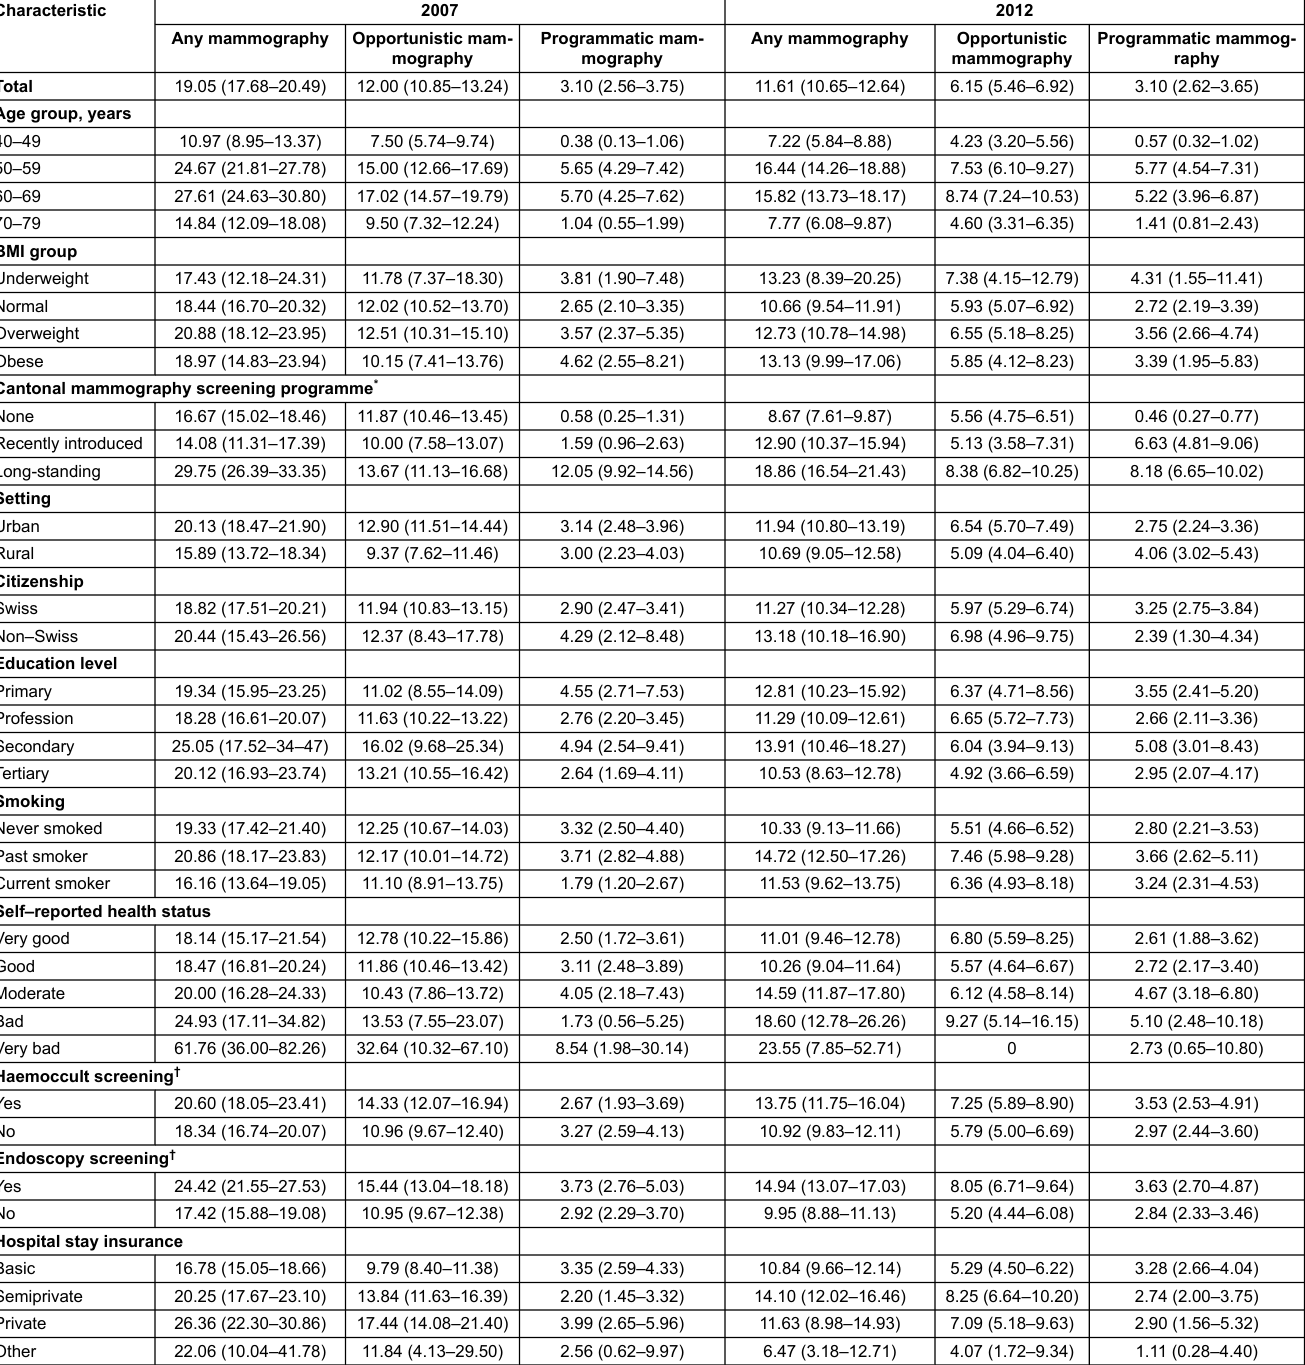
Table 1: Percent of women (with 95% confidence intervals) aged 40 to 79 years reporting having undergone different types of mammography in the last 12 months in Switzer- land, 2007 and